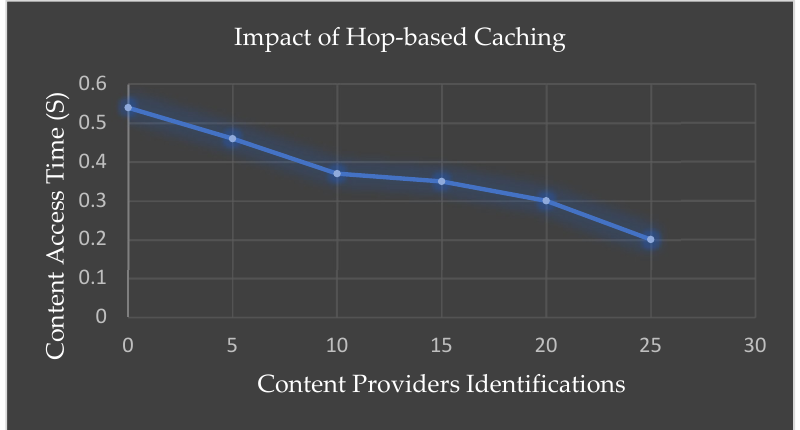
Figure 11. Impact of hop-based caching.